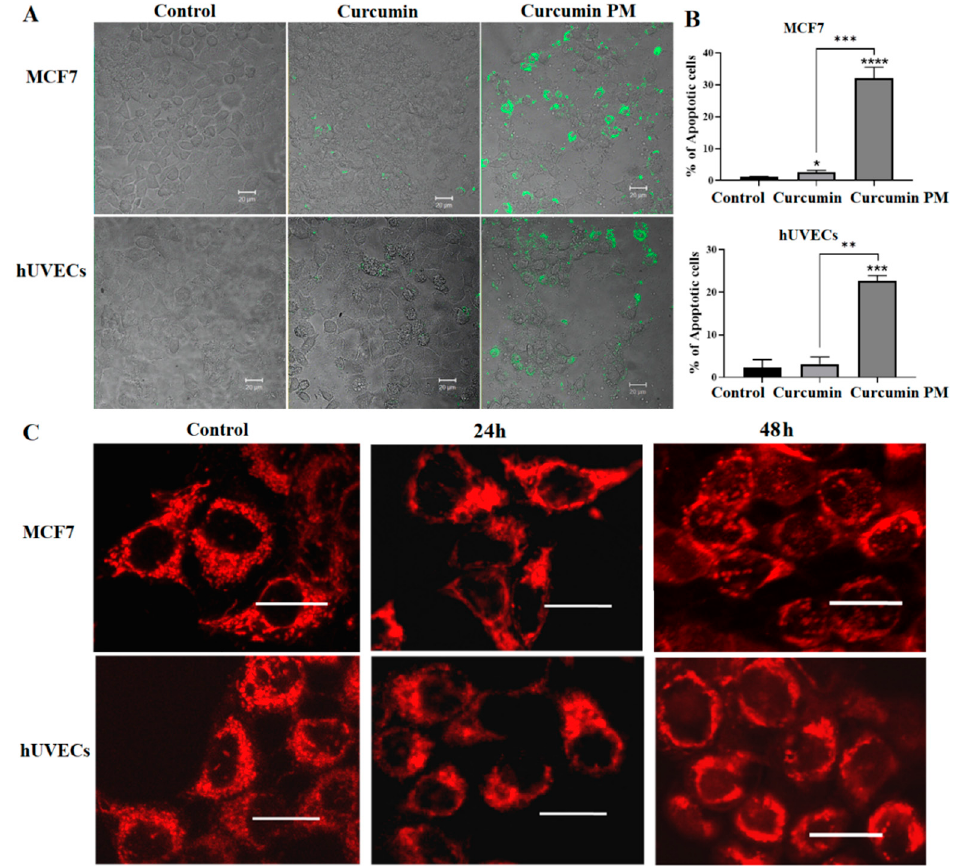
Figure 4. Curcumin-loaded micelles induced apoptosis in both hUVECs and MCF7 cells. ( A ) Annexin V staining revealed the expression of an apoptotic marker in the cells treated with curcumin PM. ( B ) The percentage of apoptotic cells after incubating with free-cucurmin and nanocurcumin at 30 µg/mL. ( C ) MitoTracker Red staining indicated the mislocalization of mitochondria in the treated cells. Treated hUVECs and MCF7 cells were incubated with MitoTracker Red (100 nM) for 30 min at 37 °C. The cells were washed with PBS and the live cells were imaged. The fluorescence signal was reduced in the samples treated with curcumin-loaded micelles, following 24 h and 48 h of incubation compared to the control. The data are presented as mean ± SD, N = 3. * p < 0.05; ** p < 0.01; *** p < 0.001; **** p < 0.0001. Scale bar: 10 µ